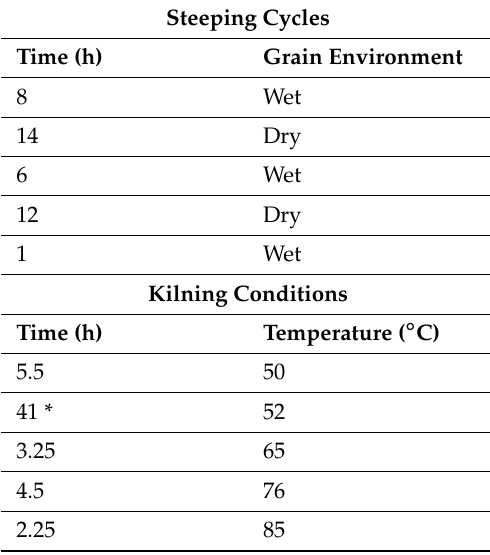
Table 1. Malting